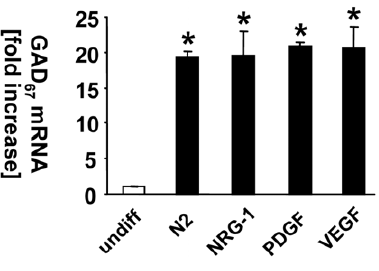
Figure 2. Screening of growth factors for GAD 67 increasing activity in differentiated HiB5 cells. Cultured HiB5 cells were switched to differentiation conditions. In the presence of PDGF, the cultured cells were treated with NRG-1 or VEGF and cells were incubated for 2 additional days. Controls were cultured in N2 medium with PDGF alone. Cells were harvested in Trizol, the total RNA